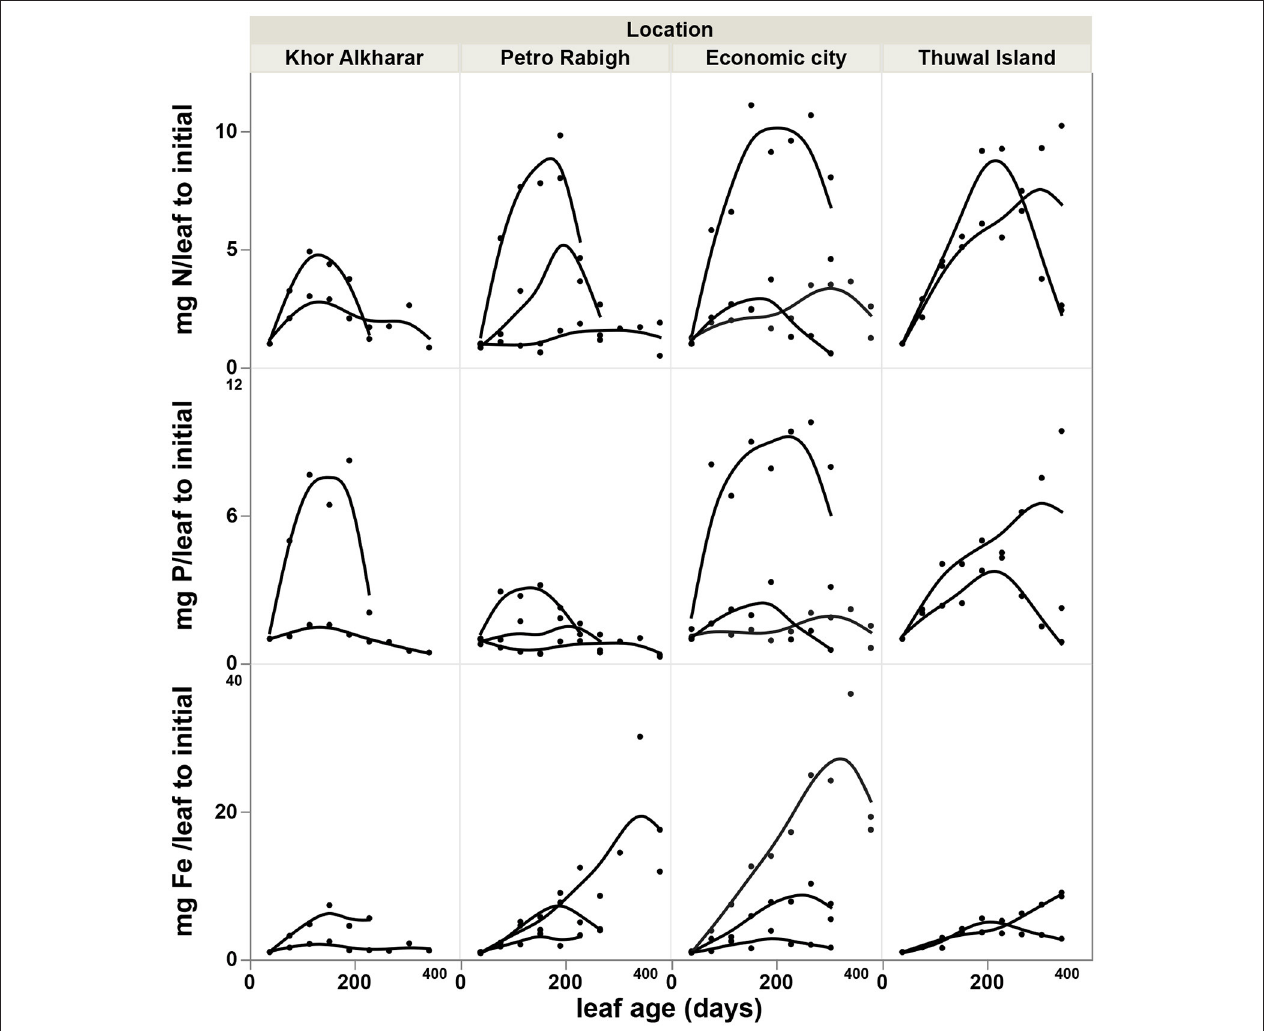
FIGURE 5 | Accumulation rate of nutrients content (difference in mg leaf − 1 relative to the value of the youngest leaf) with age of Avicennia marina leaves in the Central Red Sea, each smoothed line present one tree branch in a